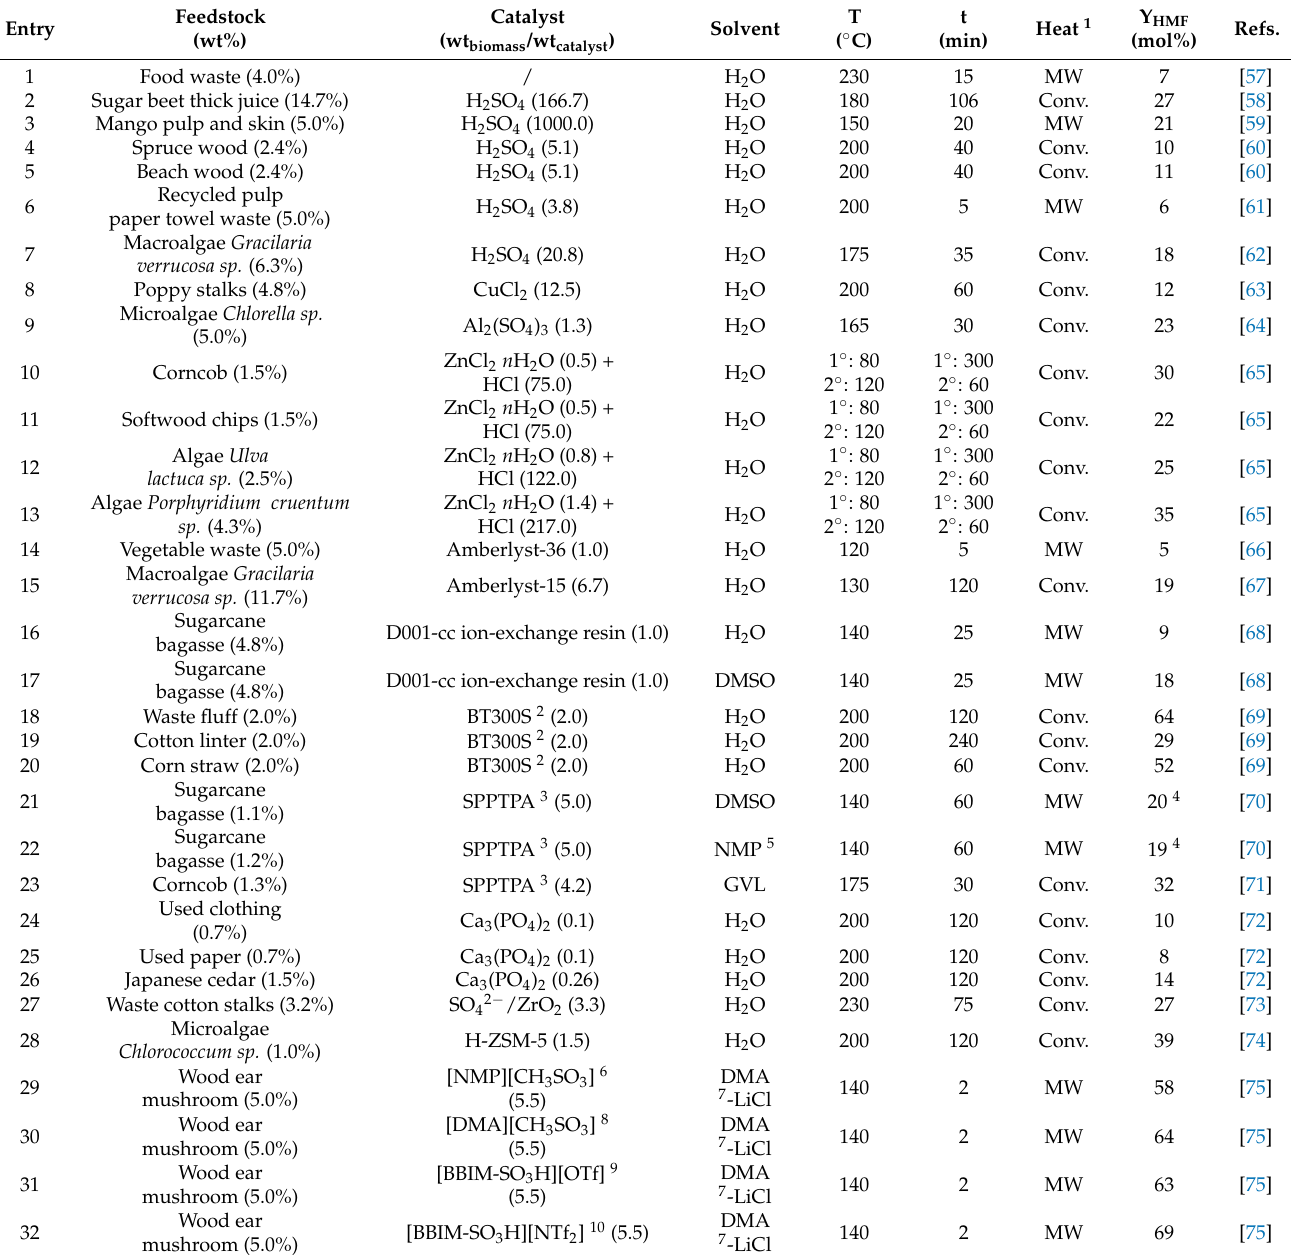
Table 1. HMF production starting from raw biomasses in one-solvent